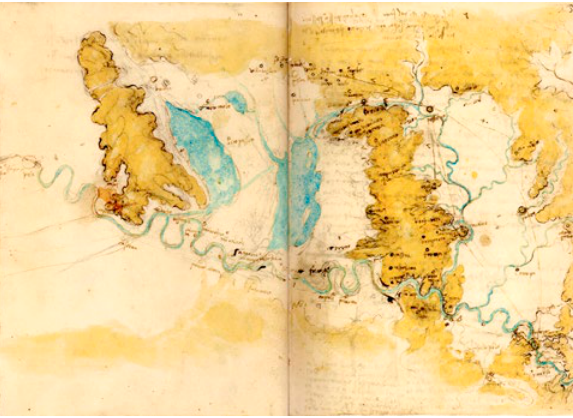
Figure 11. Map of the Lower Valdarno , Codex Madrid II, cc.